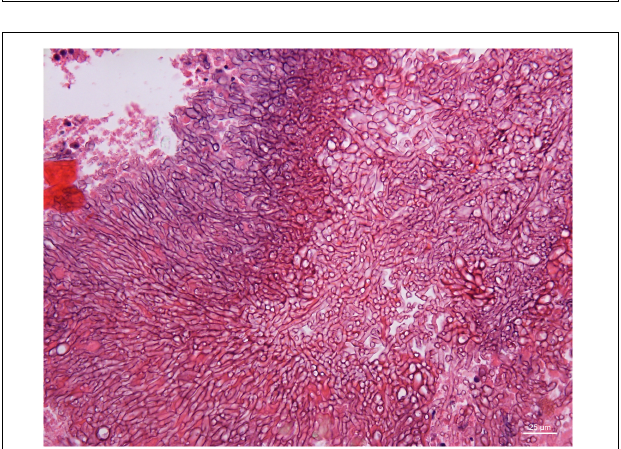
FIGURE 1 | “Extranodal natural killer/T-cell lymphoma, nasal type/rhino-orbital-cerebral mycosis.” Mucor irregularis angioinvasion and angiodestruction (H&E, original magnification × 100).